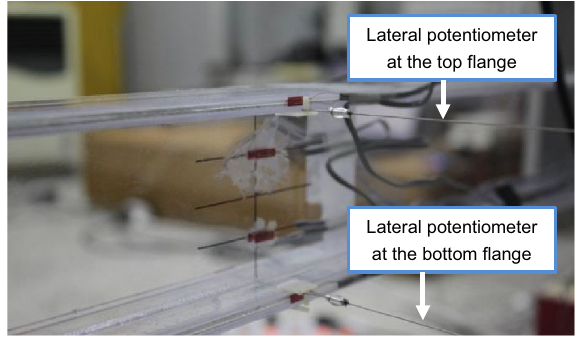
Fig. 5 Wire potentiometers for the deflection and rotation measurements.